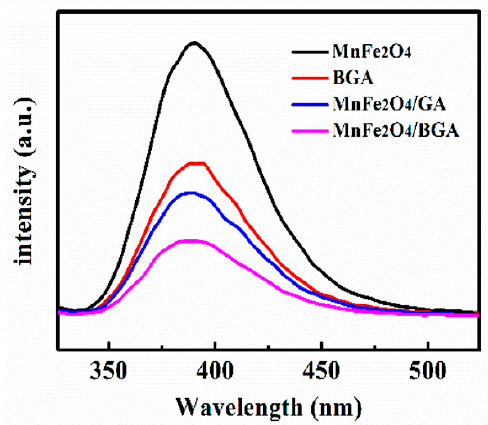
Figure 15. PL spectra of MnFe 2 O 4 , BGA, MnFe 2 O 4 /GA, and MnFe 2 O 4